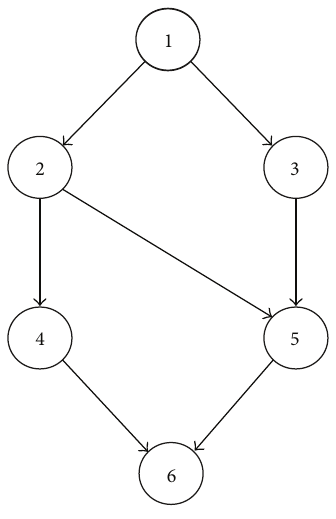
Figure 3: A sample